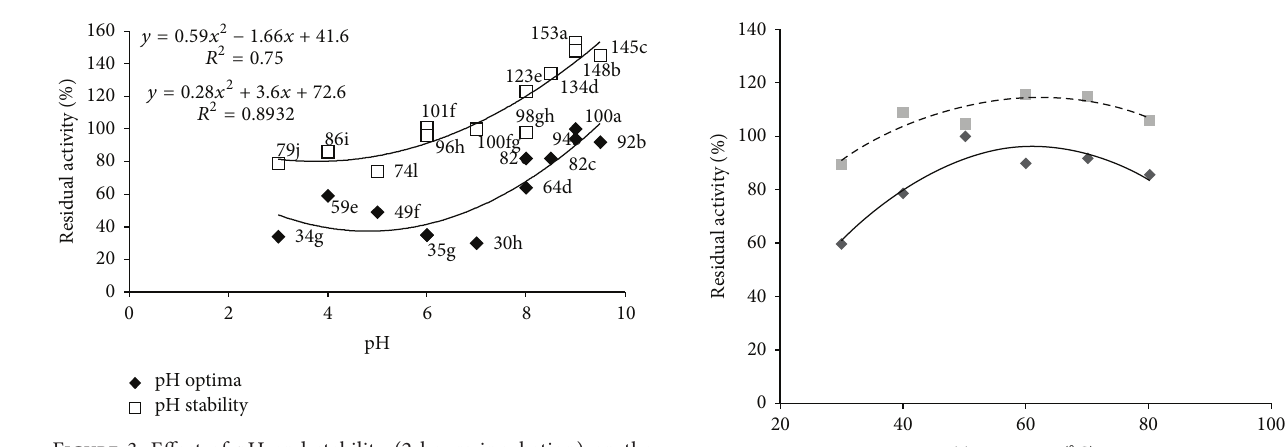
Figure 3: Effect of pH and stability (2 hours incubation) on the activity of tannase from Penicillium montanense URM 6486.